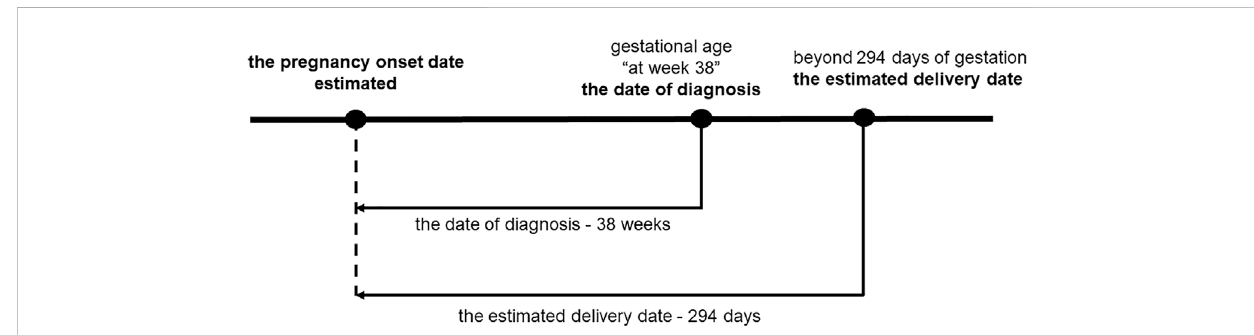
FIGURE 2 Pregnancy onset date estimations. The pregnancy onset date was estimated by subtracting the GA accompanying the diagnosis of the speci fi c visit fromthedateofdiagnosis. IncasesforwhichGAwasdiagnosedat38 weeks,38 weeksand0 daysweresubtractedfromthedateofdiagnosis.Whenthe difference between the estimated dates of pregnancy onset and delivery exceeded 294 days, pregnancy onset was considered 294 days before the estimated delivery